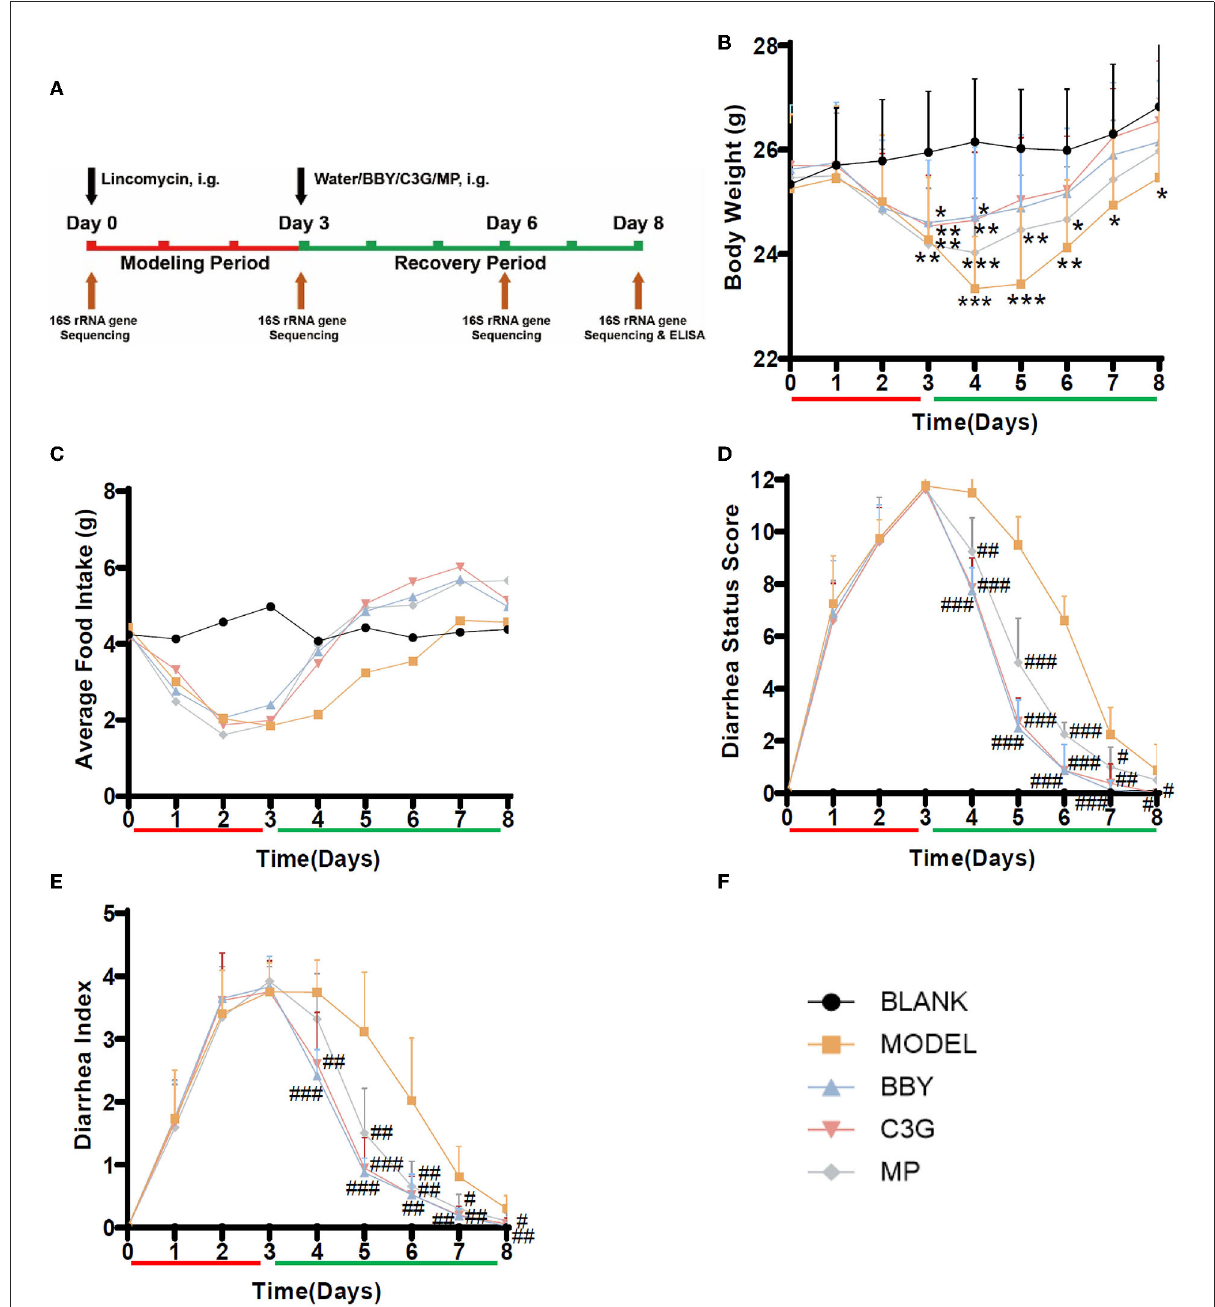
FIGURE2 (A) Experimental scheme, black arrow indicates intragastric intervention, brown arrow indicates collection of fecal or tissue samples, red is the modeling stage, green is the recovery stage. (B) Average body weight change. (C) Average food intake. (D) Diarrhea status score, (E) Diarrhea index, n = 8/group, (F) Graph legends. The results were presented as mean ± standard deviation. *Indicated a significant difference compared with the BLANK group, # indicated a significant difference with the MODEL group, where * p < 0.05, ** p < 0.01, *** p < 0.001; # p < 0.05, ## p < 0.01, ### p <